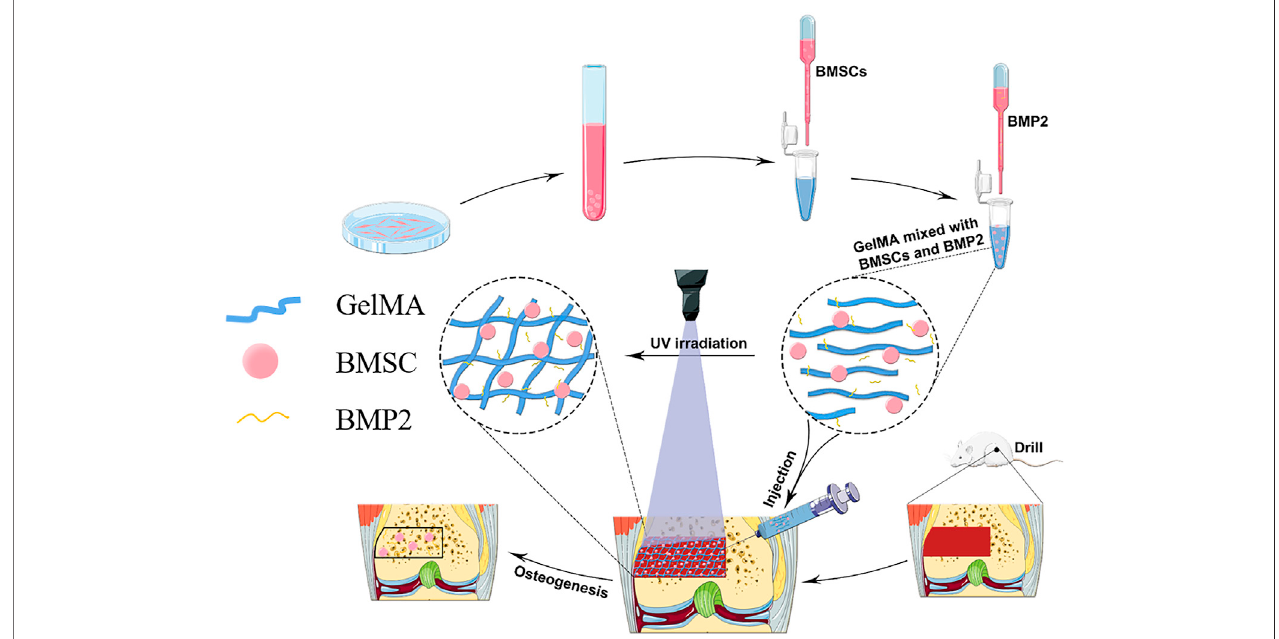
FIGURE 1 | A schematic diagram of the preparation of bioactive BMSCs-BMP2-GelMA scaffold and the experimental procedure.